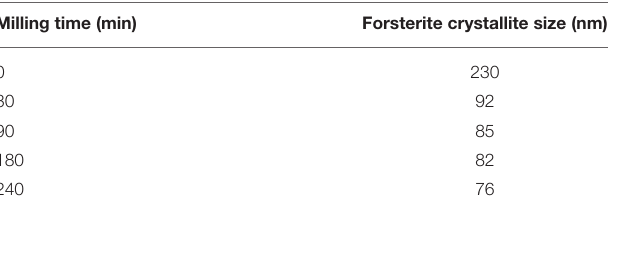
TABLE 2 | Crystallite size of the Forsterite phase, evaluated by Rietveld analysis of each sample, as a function of the milling time. Milling time (min) Forsterite crystallite size (nm)